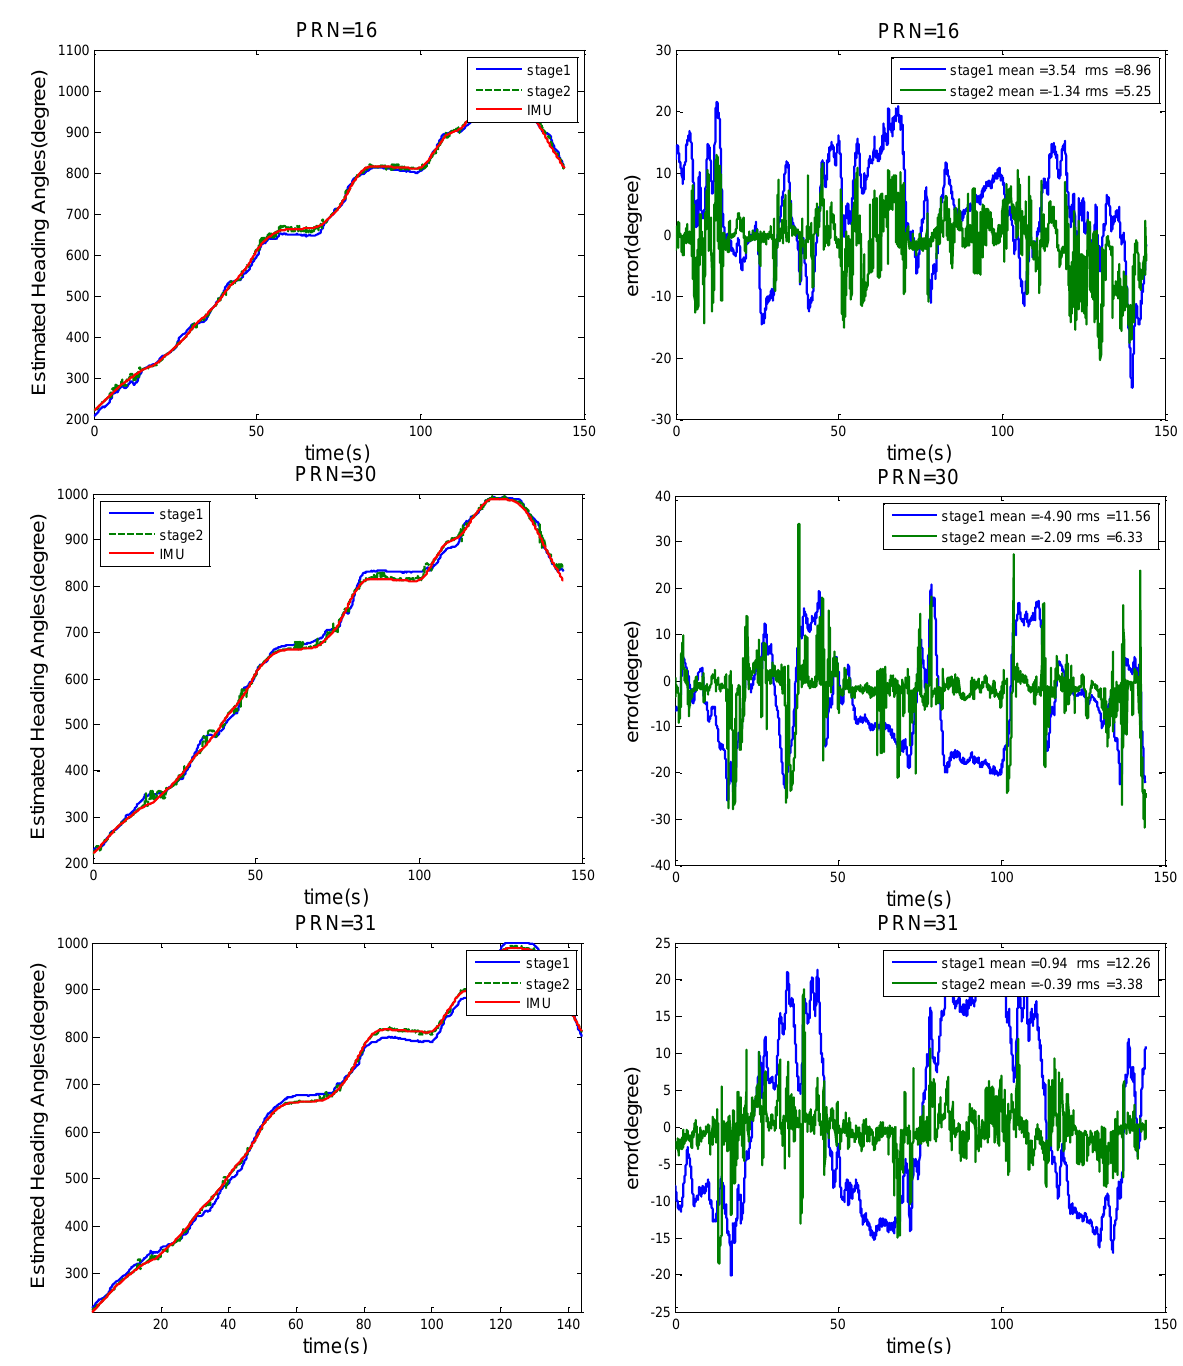
Figure 11. Heading angle determination results and the estimated errors compared to the IMU estimates for PRN 16, 30 and